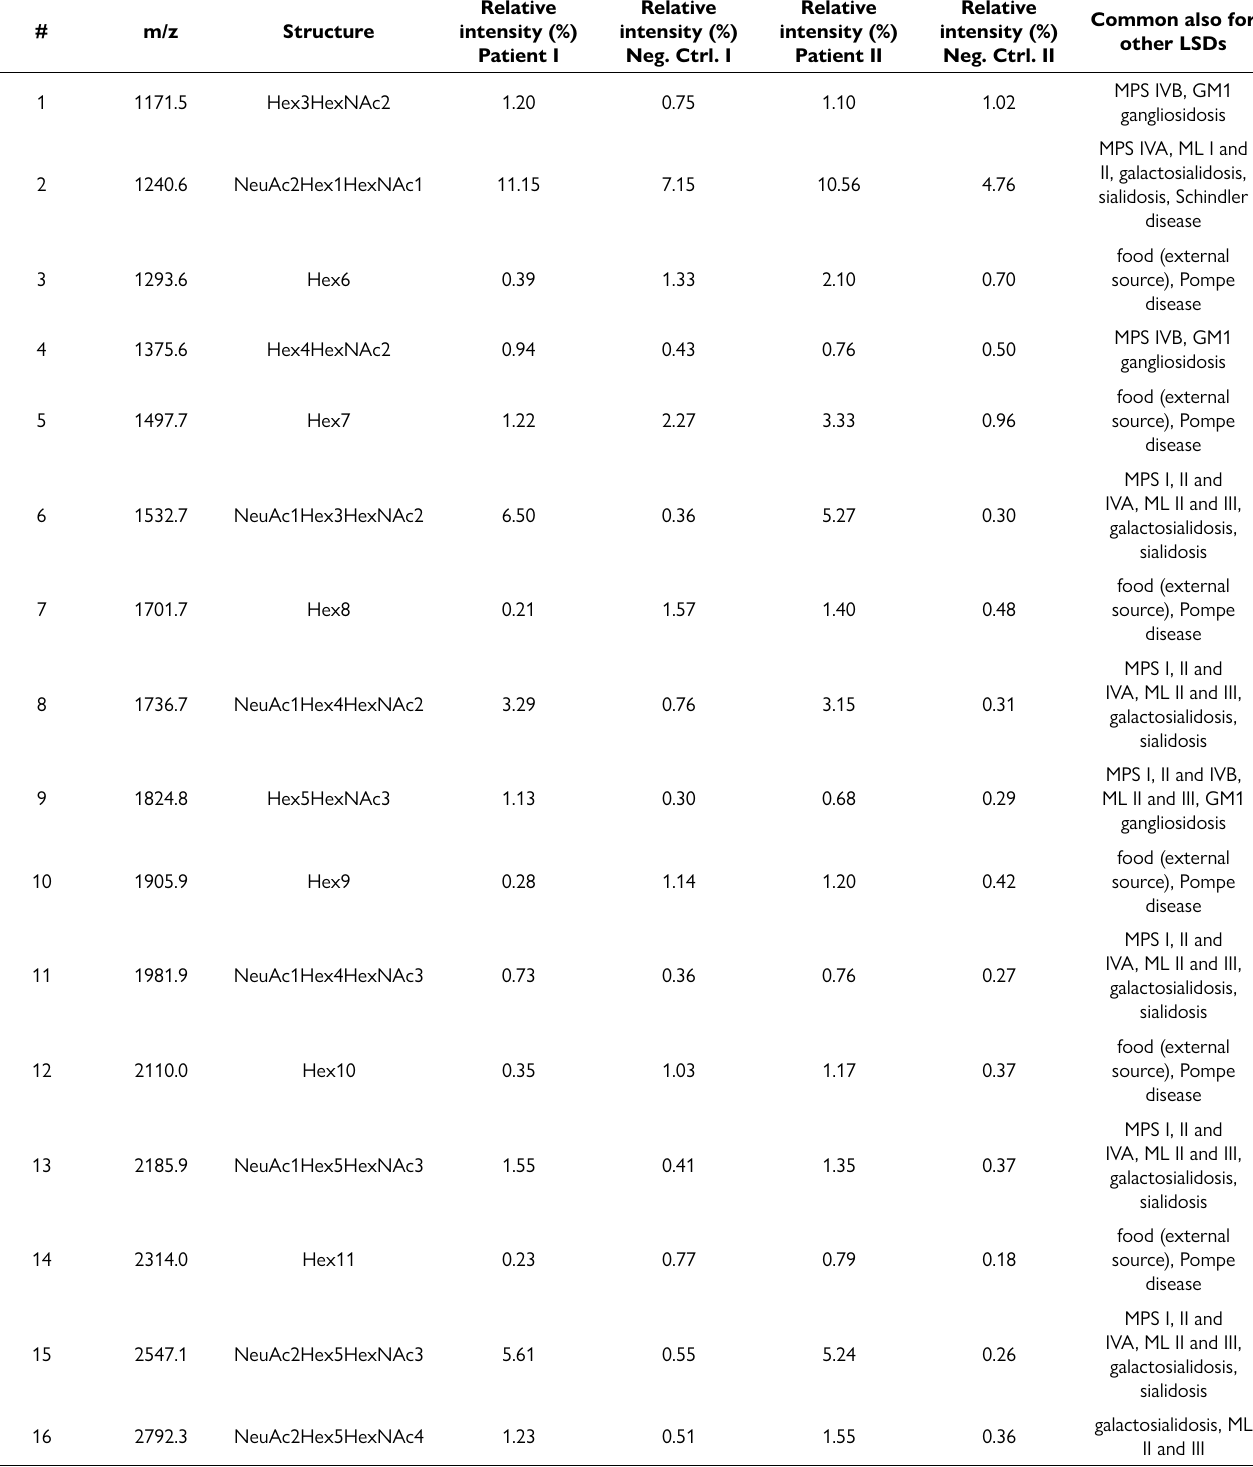
ND – not detectable. # - number of identified oligosaccharide in the